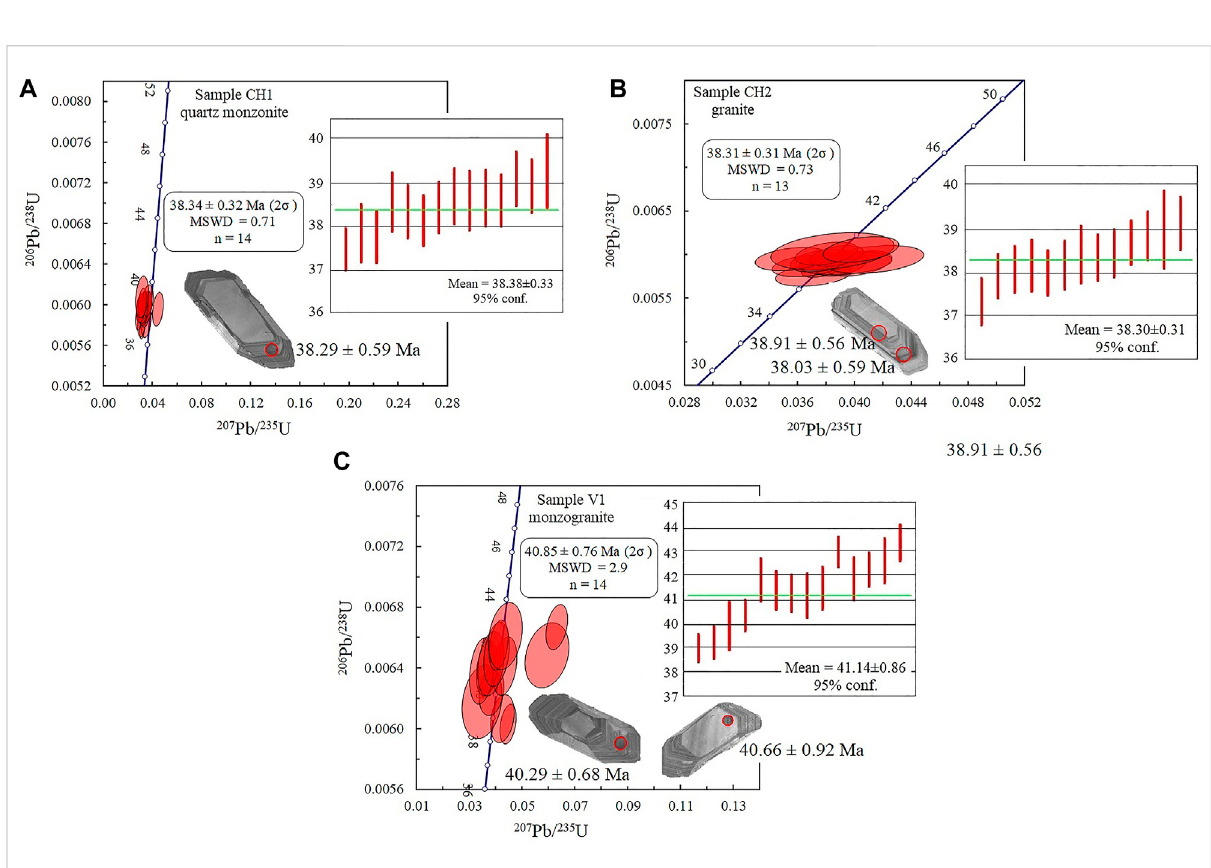
FIGURE 8 Zircon U – Pb Wetherill Concordia diagrams and representative CL images for granitoid intrusions in the Tashvir (A,B) and Varmazyar (C) deposits. Mean 206 Pb/ 238 U ages are reported with 2 σ errors. MSWD = mean square weighted deviation. N = number of spot analyses.